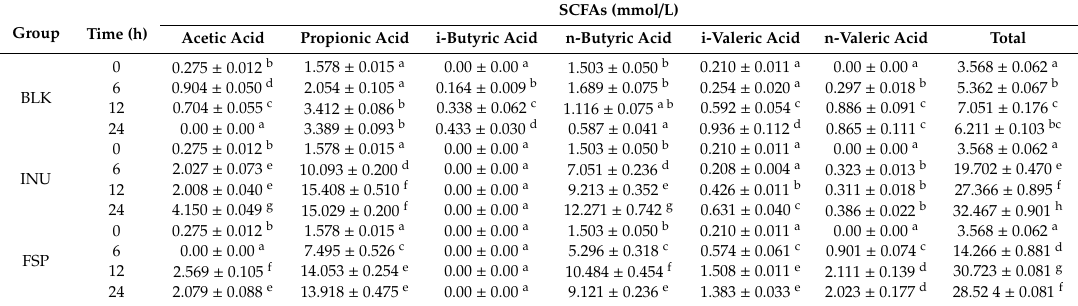
Table 3. The concentrations of SCFAs in fermentation solutions at di ff erent time points of fermentation. Group Time